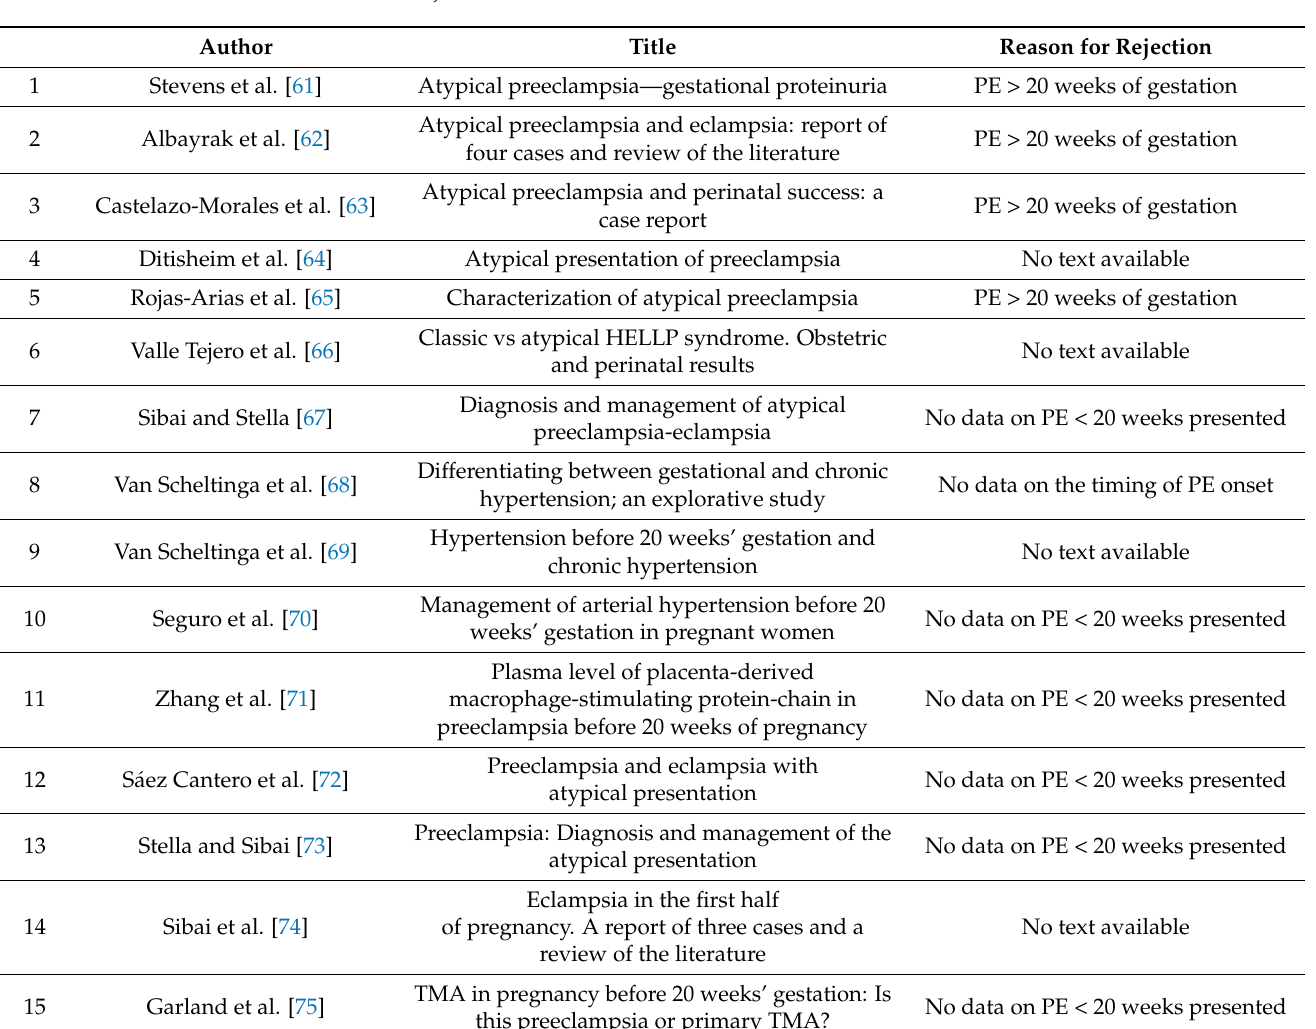
Table 4. Rejected after full-text